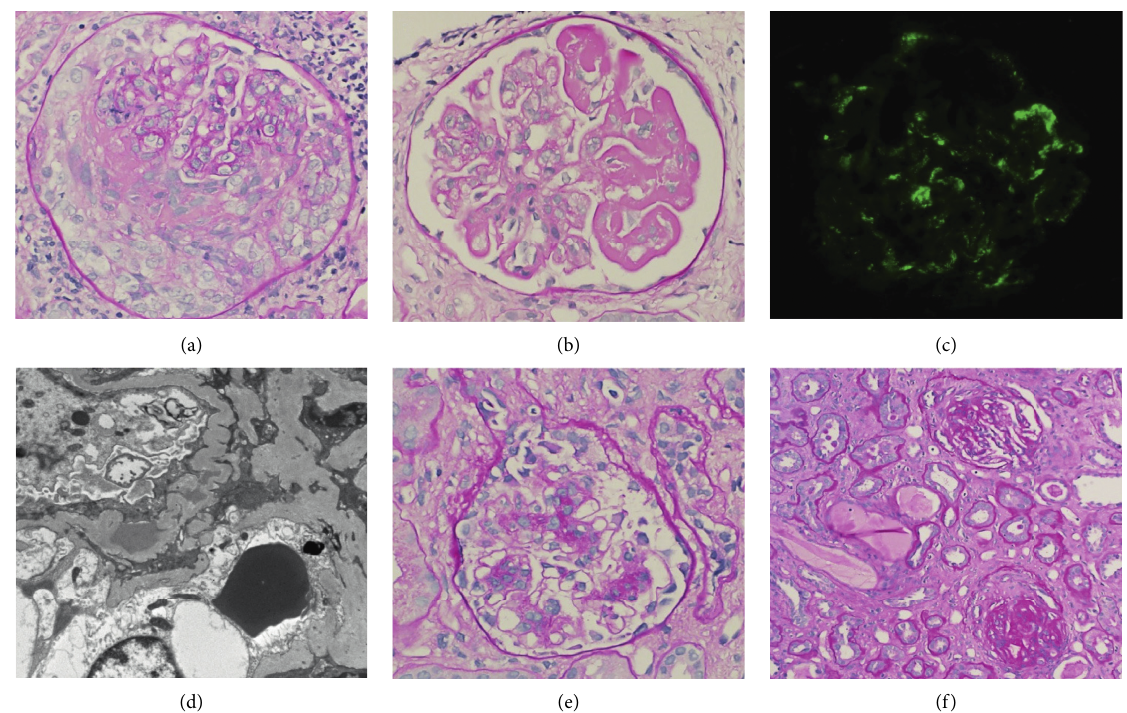
Figure 4: Findings of the second and third kidney biopsies, at three weeks (a, b) and five months (c–f) after surgical resection of clear cell renal cell carcinoma, respectively. Sequential biopsies demonstrate progression and transition from active lesions (a, b) to sclerosing lesions (e, f), and dramatic clearance of glomerular IgA deposits following tumor resection (c, d). (a) A representative glomerulus shows endocapillary hypercellularity and a nearly circumferential cellular crescent with necrosis. (b) Segmental large subendothelial deposits (right half of the glomerulus) are visible by light microscopy. (c) Immunofluorescence staining of IgA shows only modest glomerular mesangial and capillary wall IgA deposition. (d) Electron microscopy shows a small number of electron dense deposits mainly in mesangium. (e) Nonsclerosed glomeruli show only mild mesangial hypercellularity without endocapillary hypercellularity. (f) Representative glomeruli with fibrous crescents, one globally sclerotic (the lower glomerulus) and the other segmentally scarred (the upper glomerulus). The third biopsy shows significant chronic changes with approximately 35% global glomerulosclerosis and additional 35% glomeruli with fibrous crescents and segmental sclerosis. There is severe tubulointerstitial scarring. Original magnification: 400X in (a–c) and (e), 8000X in (d), and 200X in (f).